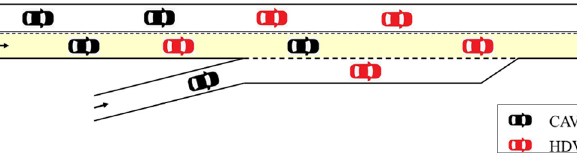
Figure 3 Merging scenario of single-lane freeways with mixed traf fi